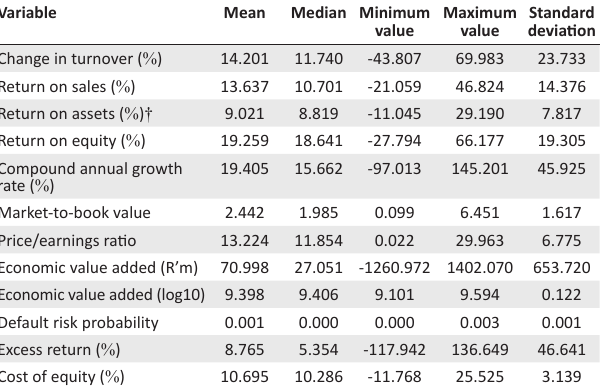
TABLE 7: Descriptive statistics for the financial health variables.